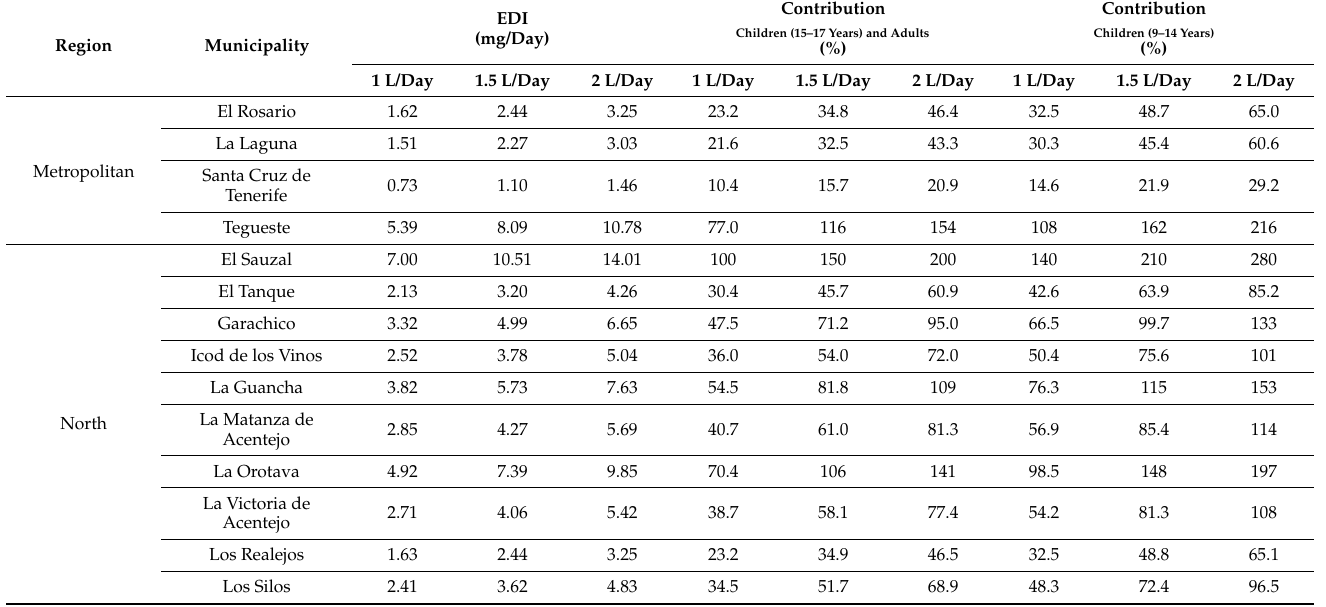
Table 5. Estimated Daily Intake (EDI) and percentage contribution from consumption of Tenerife water supply by children (9–14 and 15–17 years old) and